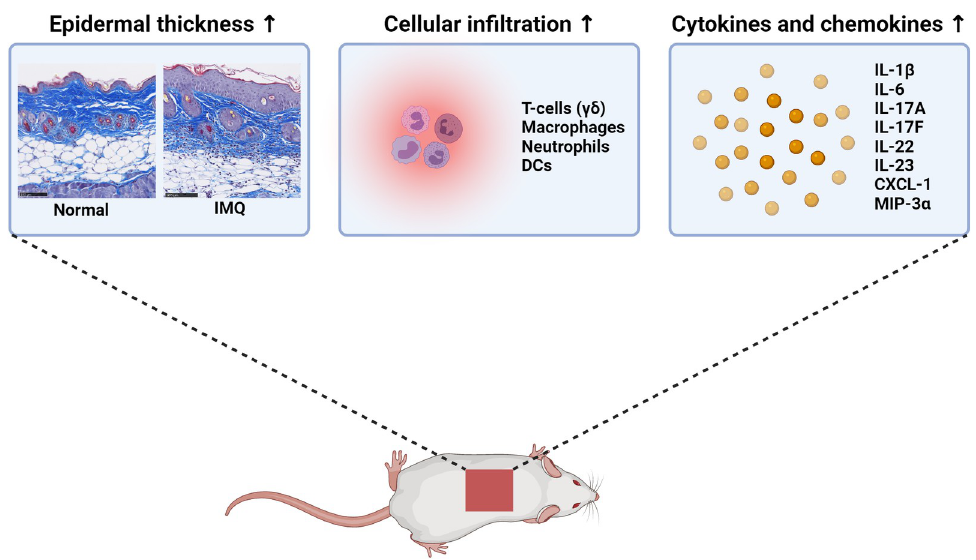
Fig 1. Characteristics of IMQ induced skin inflammation in wild-type mice. Topical application of IMQ results in increased epidermal thickness, infiltration of various immune cells and release of several pro-inflammatory cytokines and chemokines relevant for psoriasis. The figure has been created with BioRender.com and the read-outs are mainly from published data (cellular infiltration, cytokines and chemokines), but un-published in-house data (epidermal thickness pictures) are also